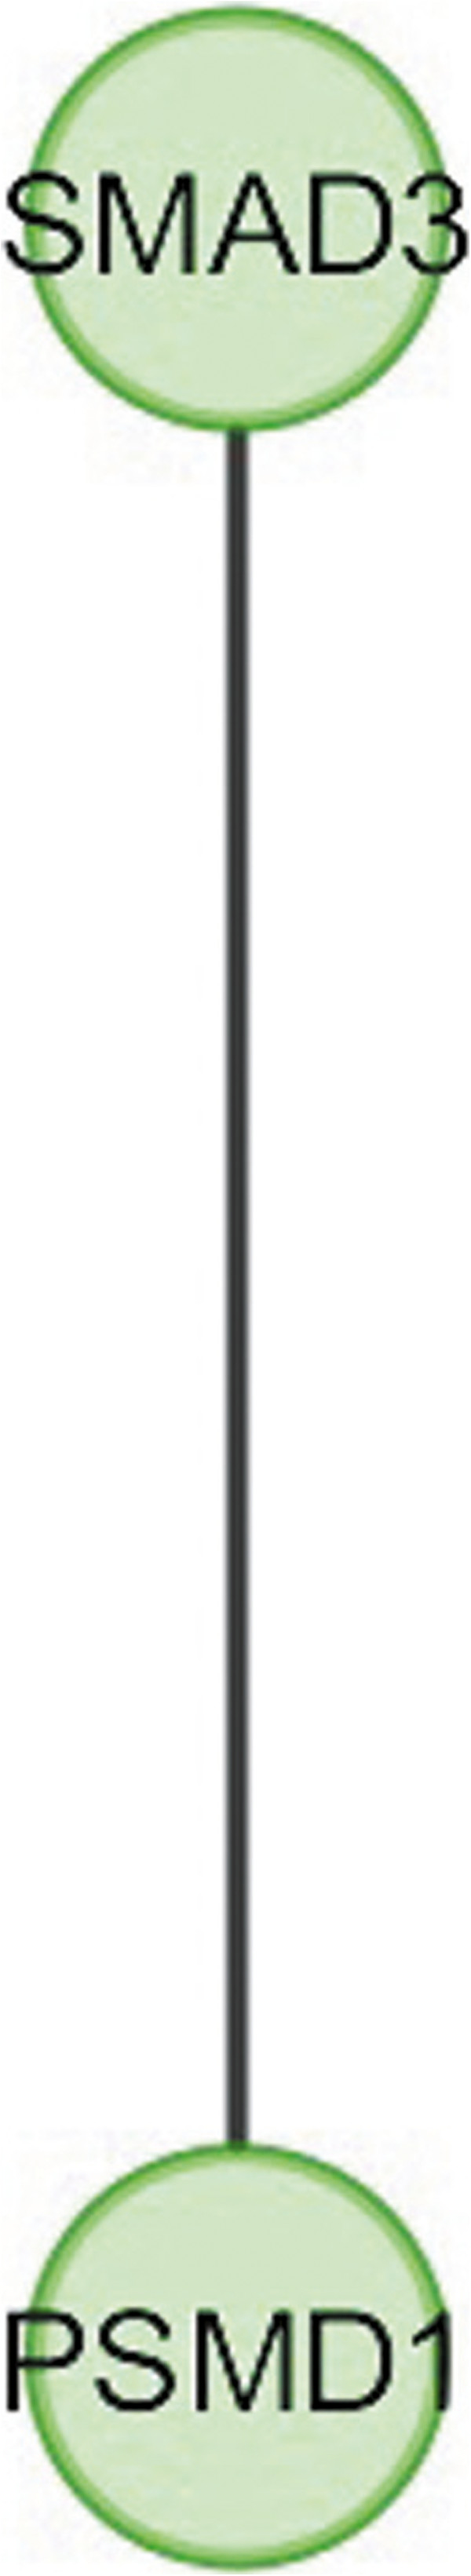
Overlapping module in normal condition of bone.